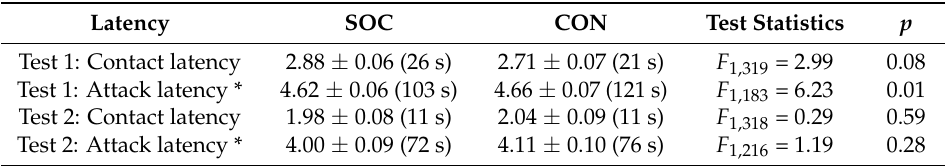
Table 4. Latency for the resident to contact and to attack the intruder, in test 1 and test 2, for pigs that were socialized (SOC) or not socialized (CON). Values are LSmeans with SE for log transformed values, whereby raw values in seconds are given in